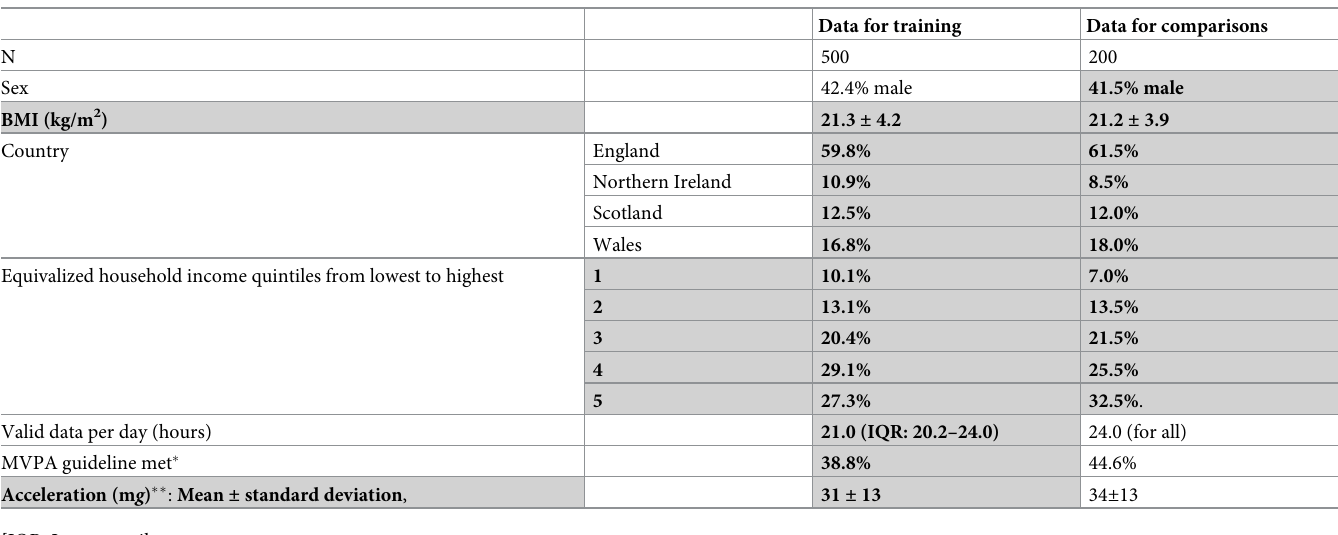
Table 1. Characteristics of